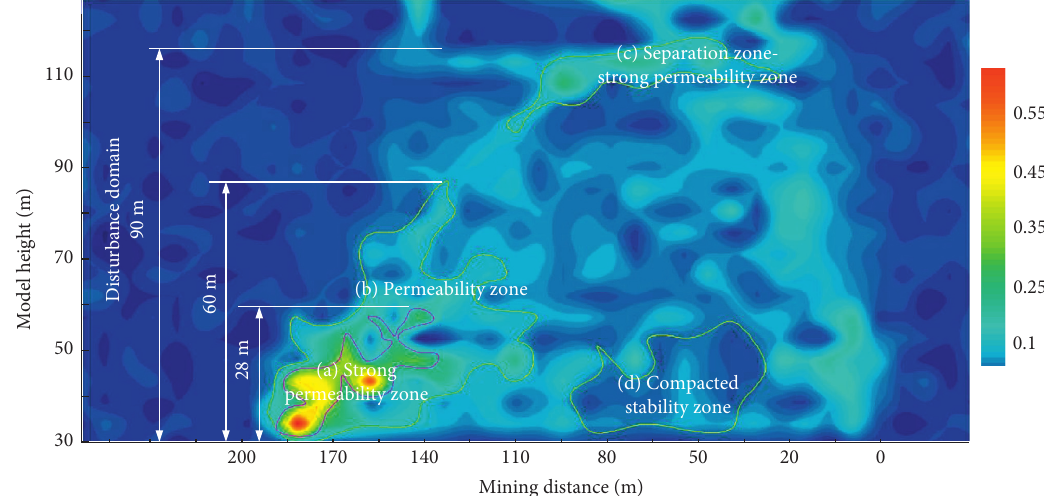
Figure 17: Permeability zoning in goaf when excavated to 190 m of scheme 1. The porosity distribution of scheme 1 is shown in Figure 17, and the permeability zone is divided into four regions. (a) Strong permeability zone ， the porosity rate in this area is generally greater than 0.25, mainly due to the coal gangue accumulation holes and vertical fissures of rock collapse, and dynamic changes with the advance of the working face, which can directly affect the working face. (b) Permeability zone ， the porosity of this area is between 0.1 and 0.35, and it is mainly composed of vertical fissures, and the influence range can reach 60 m in the vertical direction, and if the above contains aquifer, it may directly affect the working surface. (c) Separation zone ， the porosity of this area is 0.25–0.35, mainly composed of separation lateral fissures, which may become a water storage space if the rock formation contains water, but has less impact on the working surface. (d) Compacted stability zone ， the porosity of this area is generally below 0.1, mainly because the coal gangue in the goaf is compacted under the action of the load above, and the stress is gradually recovered by the stress-relaxation area, resulting in the reduction of porosity. The water conductivity of this area is weak and has little influence on the working